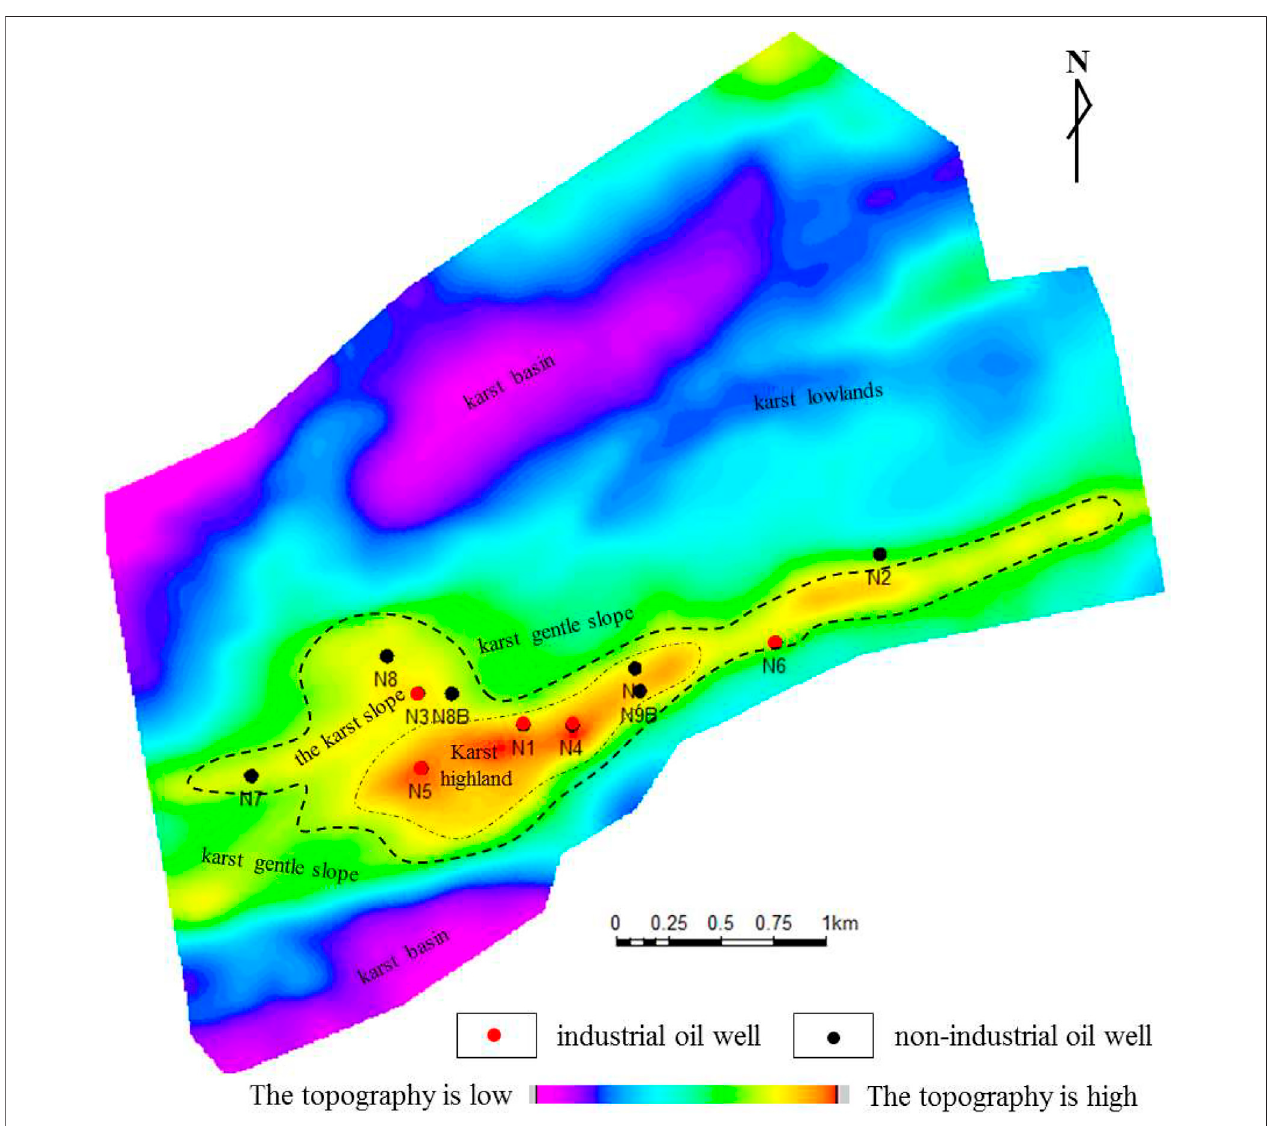
FIGURE 8 | Distribution of the ancient karst landform in the Weizhou 1 – N oil fi eld.